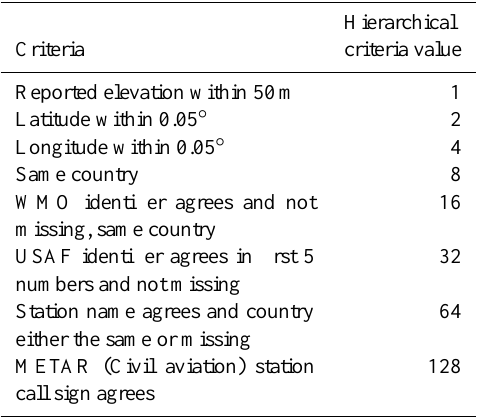
Table 1. Hierarchical criteria for deciding whether given pairs of stations in the ISD master listing were potentially the same station and therefore needed assessing further. The final value arising for a given pair of stations is the sum of the values for all hierarchical criteria met, e.g. a station pair that agrees within the elevation and latitude/longitude bounds but for no other criteria will have a value of 7.